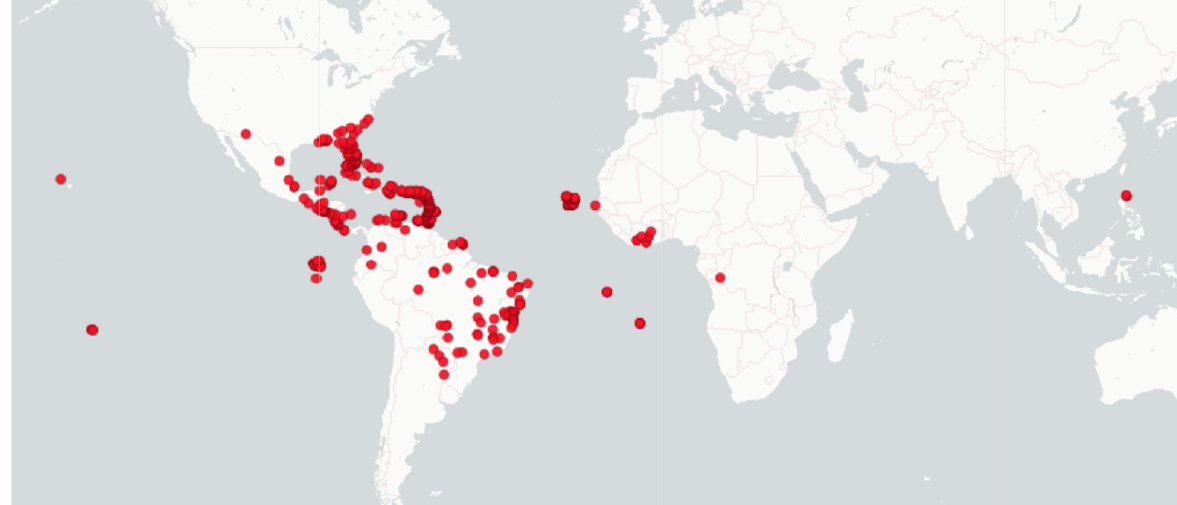
Fig 1 . Geographic distribution of Solenopsis globularia records. Map created using carto.com.